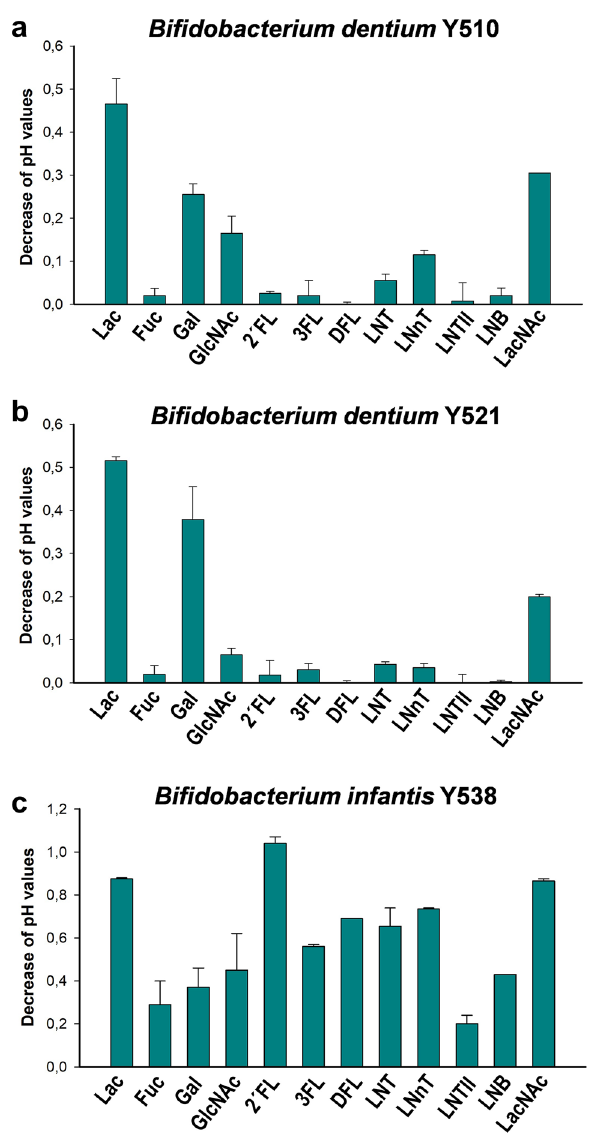
Figure 1. Carbohydrate utilization profiles of Bifidobacterium dentium Y510 ( a ), B. dentium Y521 ( b ) and Bifidobacterium infantis Y538 ( c ). MRS basal medium supplemented with 2 mM of carbohydrates was used. pH decrease values of culture supernatants are shown. Data presented are mean values based on at least two replicates. Errors bars indicated standard deviations. Lac lactose, Fuc l-fucose, Gal galactose, GlcNAc N -acetylglucosamine, 2 ′ FL 2 ′ -fucosyllactose, 3FL 3-fucosyllactose, DFL difucosyllactose, LNT lacto- N -tetraose, LNnT lacto- N -neotetraose, LNTII lacto- N -triose, LNB lacto- N -biose, LacNAc N -acetyllactosamine.